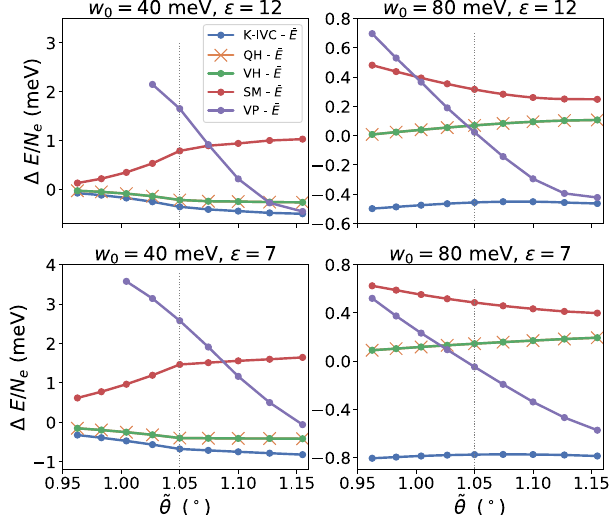
FIG. 2. Energies per electron at charge neutrality in the K-IVC, QH, VH, SM, and VP states relative to the average energy of the ¯ E K-IVC, QH, VH, and SM (denoted as ). Results are obtained at θ ¼ 1 . 05 ° as a function of 100 ≤ w ≤ 120 [meV] ( x axis) for 1 w 0 ¼ 40 and 80 meV and ϵ ¼ 7 and 12. For convenience, we ˜ θ define ¼ 1 . 05 ° × ð 110 =w 1 ½ meV (cid:3)Þ in order to convert w 1 to a qualitatively equivalent angle. The dashed vertical line shows the first magic angle. Results were obtained using six moir´e bands per spin and valley, and a 24 × 24 momentum grid. Note that the energies of the VH and QH states are numerically identical.